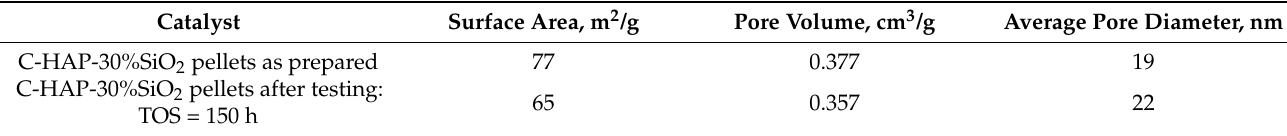
Figure 11. N 2 -adsorption and desorption isotherms ( a ) and pore size distributions ( b ), recorded before and after testing in the conversion of hydrous ethanol to 1-butanol. Table 4. Texture parameters of C-HAP-30%SiO 2 pellets before and after testing in the conversion of hydrous ethanol to